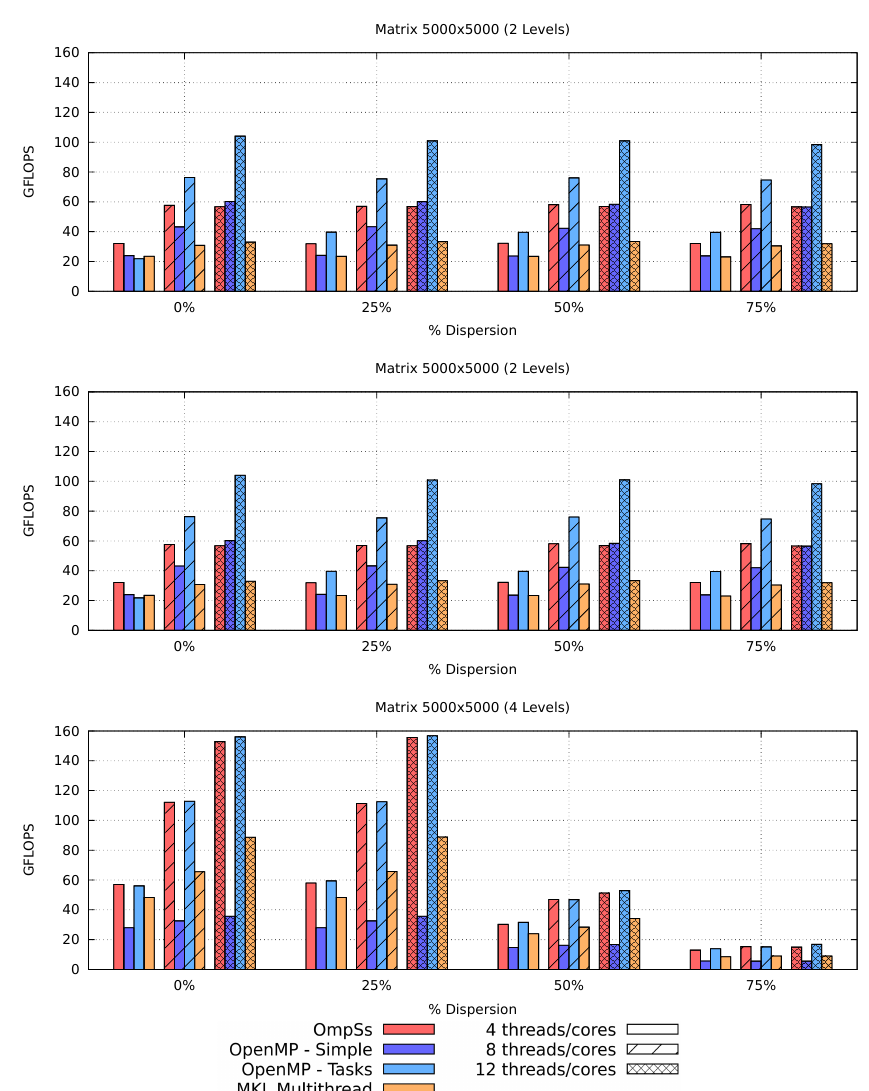
Fig. 5 Performance of the task-parallel H -Cholesky factorization of a matrix of order 5,000 using OpenMP and OmpSs in the Intel E5-2603v3 server using 4, 8 and 12